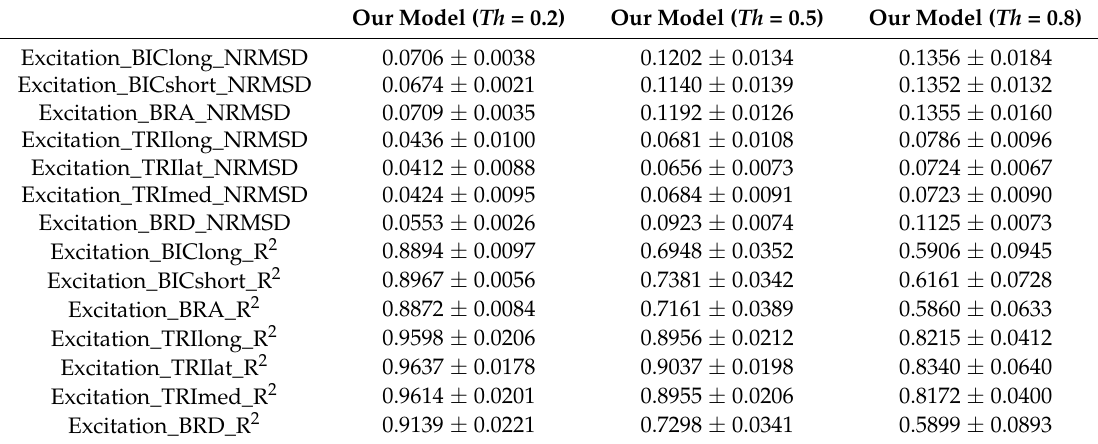
Figure 8. Experimental muscle excitations and adjusted muscle excitations with different Th values: ( a ) Th = 0.2; ( b ) Th = 0.5; ( c ) Th = 0.8. The black and red solid lines represent the average experimental and adjusted muscle excitations, respectively. The black and red dash dotted lines represent the standard deviations of the experimental and adjusted muscle excitations respectively. Table 2. Comparison between experimental and adjusted muscle excitations with different Th values (the data are given as mean ± SD).